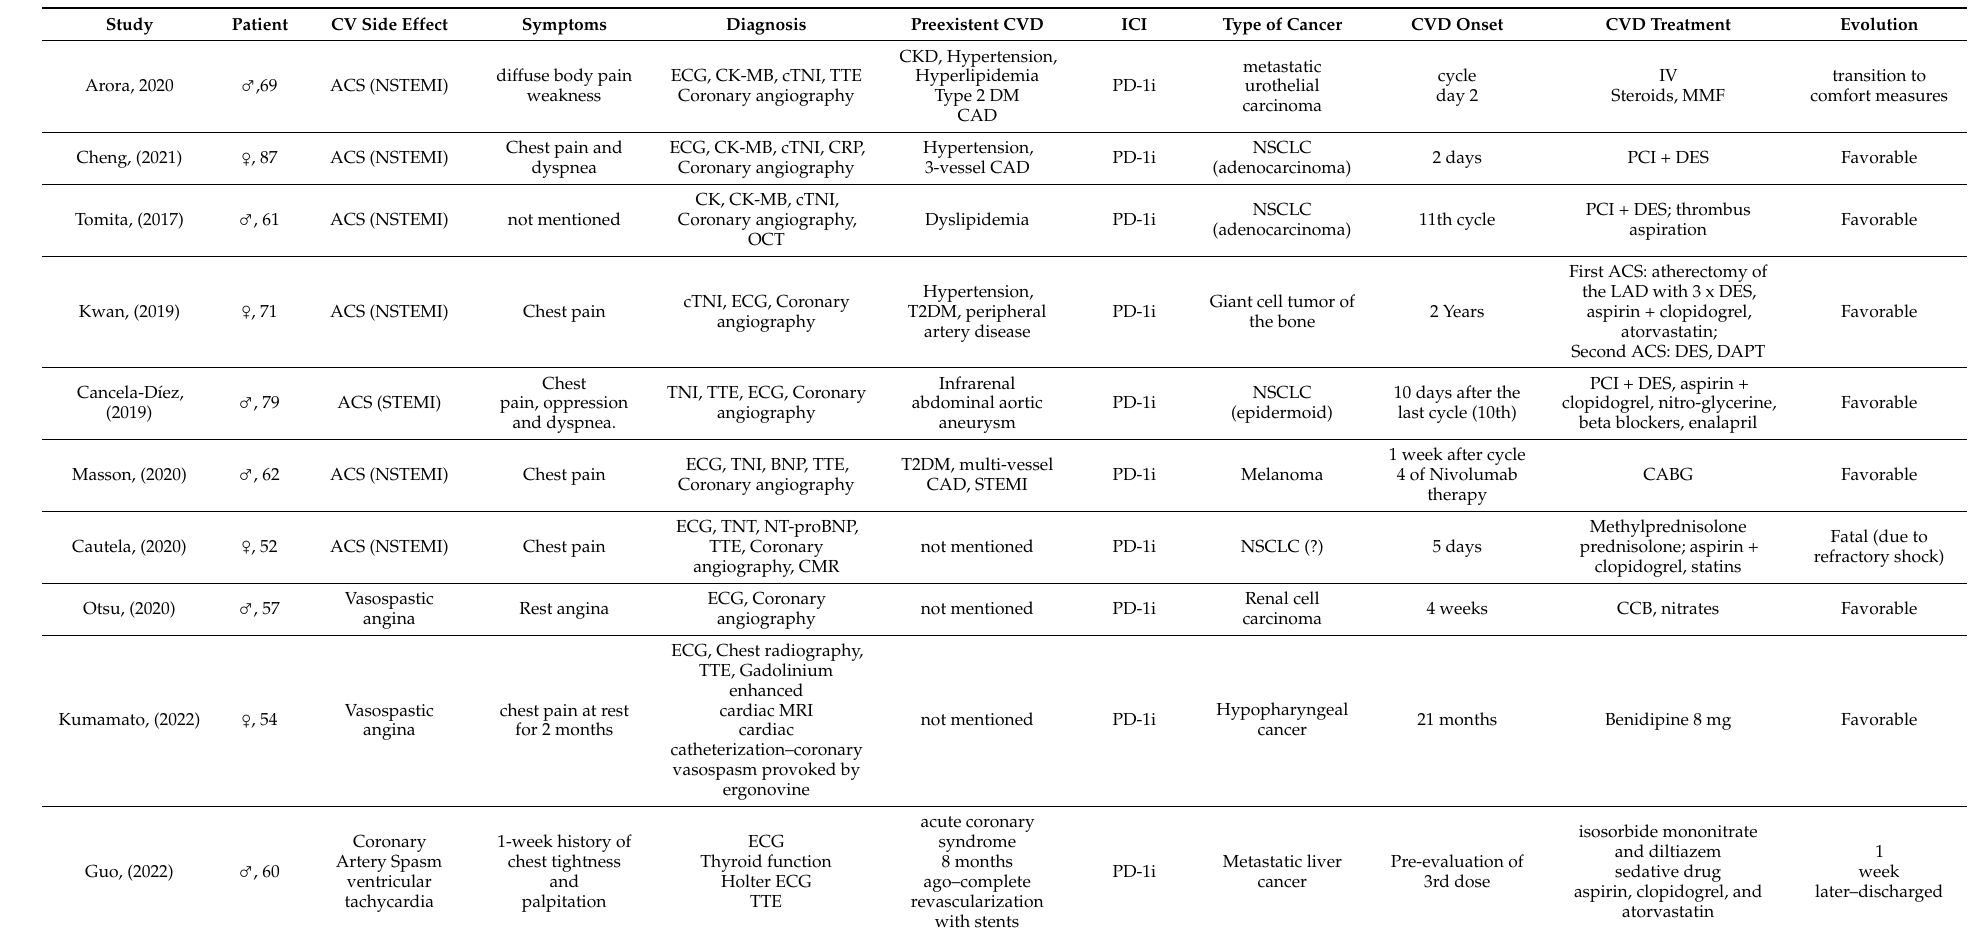
Table 5. Case reports with ICI-related acute coronary